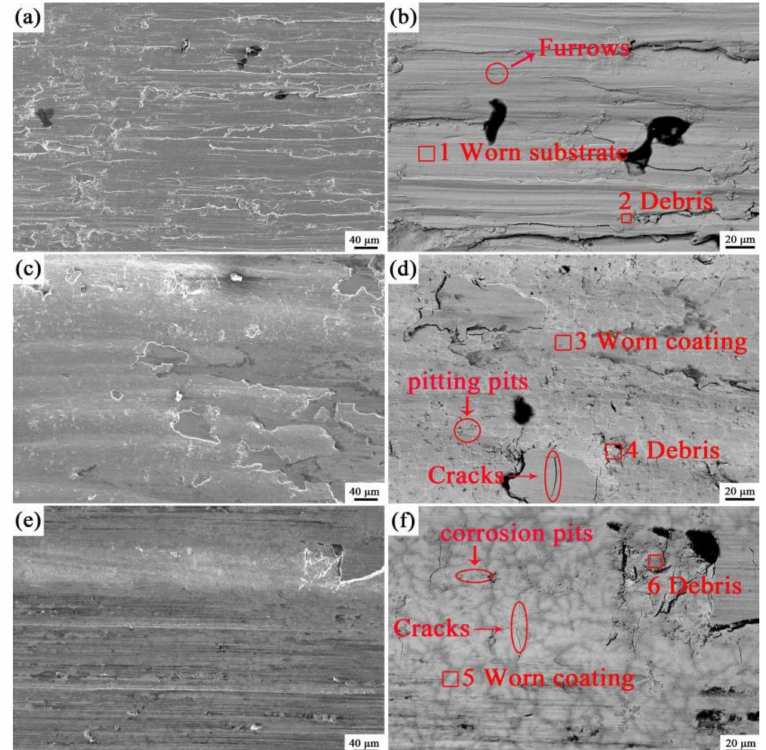
Figure 12. Wear morphologies of substrate and coatings subject in NaOH solution (pH = 11): ( a , b ) substrate; ( c , d ) coating without Ta; ( e , f ) coating with